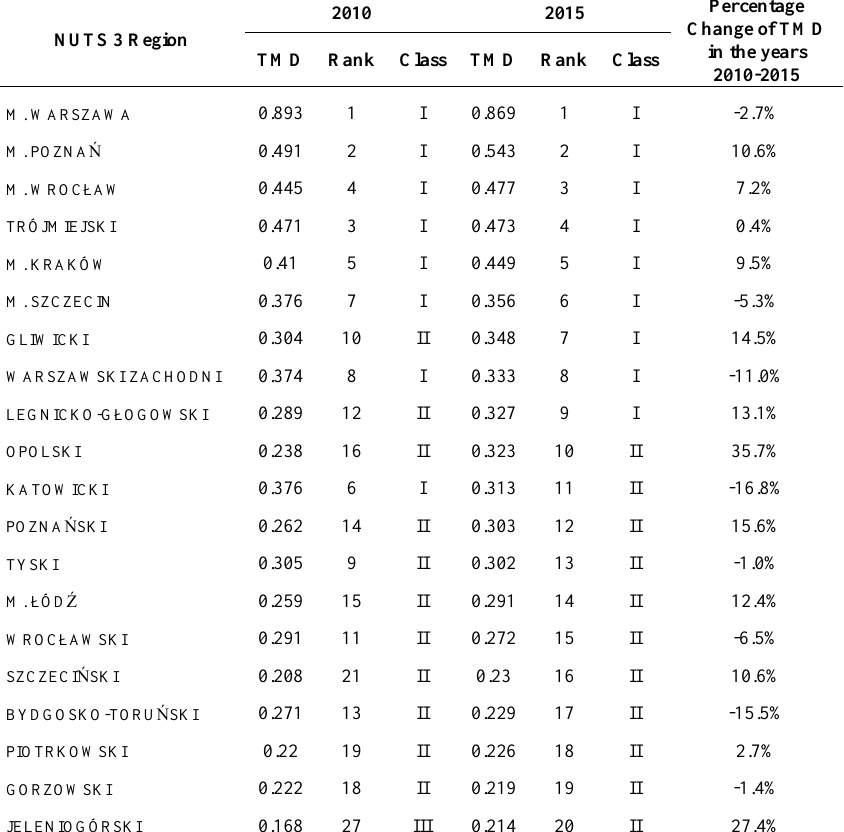
Table 2. Ranking and grouping of NUTS 3 regions in regard to entrepreneurship